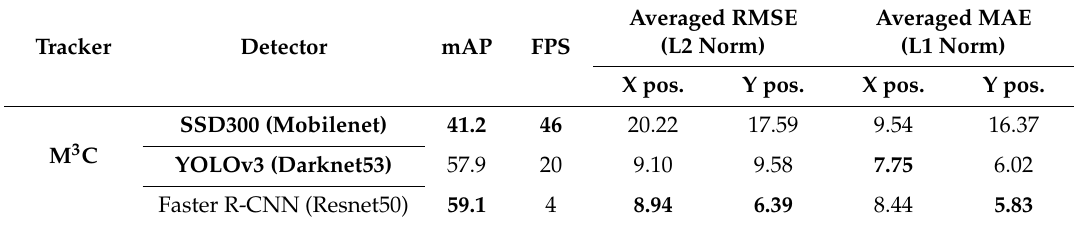
Table 4. Detector performance in the ablation study. We replaced the detector with SSD and faster regions with CNN features (R-CNN), respectively, for these ablation